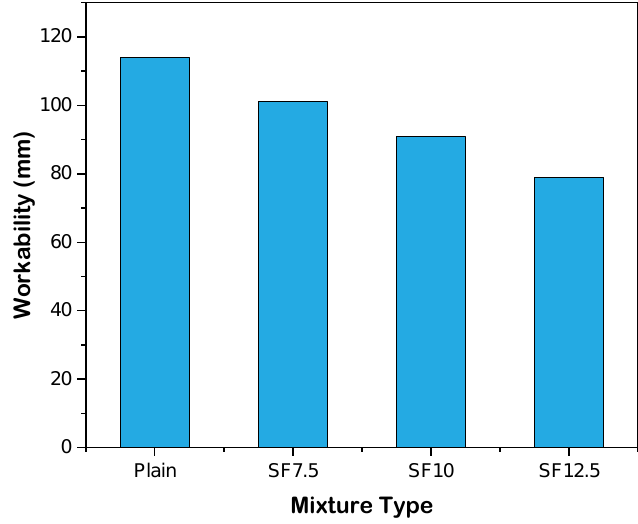
Figure 4. Workability of mixture blended with